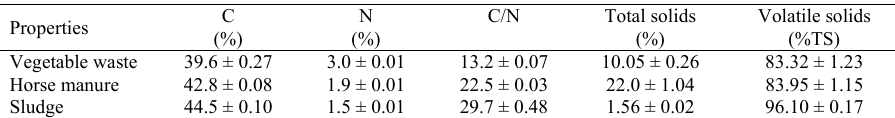
Table 1: Properties of the raw substrates